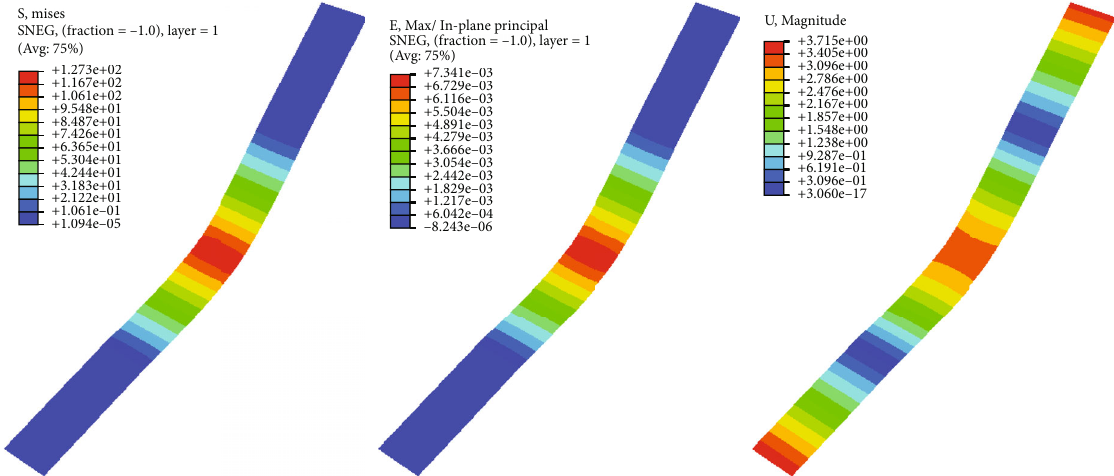
Figure 6: Stress, strain, and displacement nephogram of sandwich equivalent model.